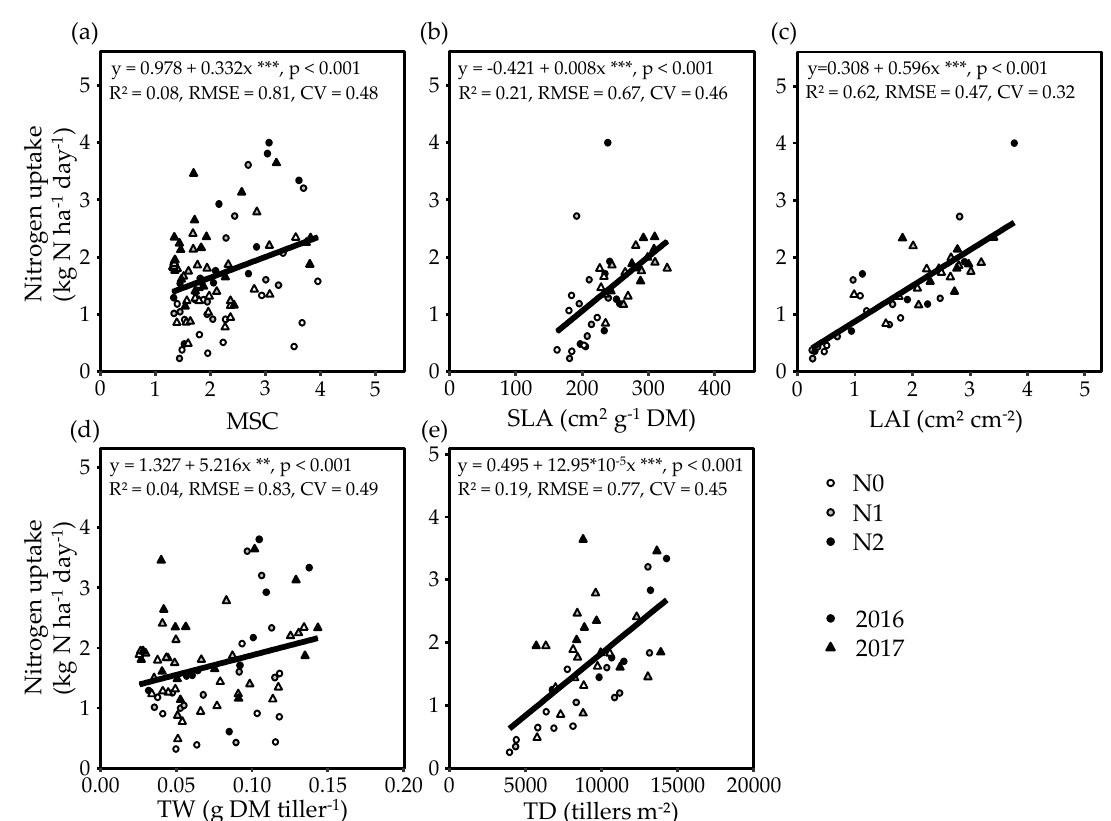
Figure 6. Linear relationships between crop growth rate (CGR) and ( a ) mean stage by count (MSC), ( b ) specific leaf area (SLA), ( c ) leaf area index (LAI), ( d ) tiller weight (TW) and ( e ) tiller density (TD) for three N application rates (0 (N0), 140 (N1) and 280 (N2) kg N ha − 1 ) across two years (2016 and 2017).